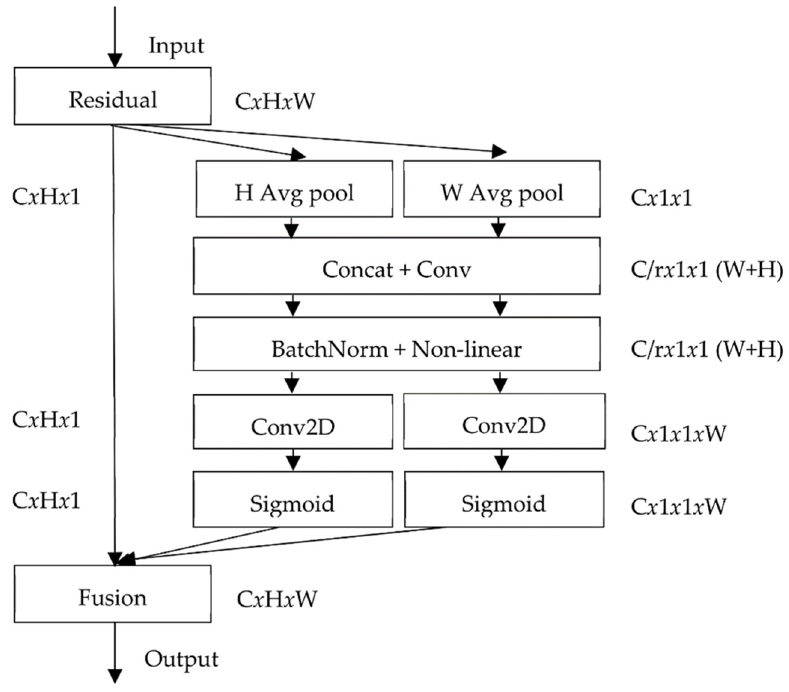
Figure 3. Structure of the coordinate attention (CA) module.